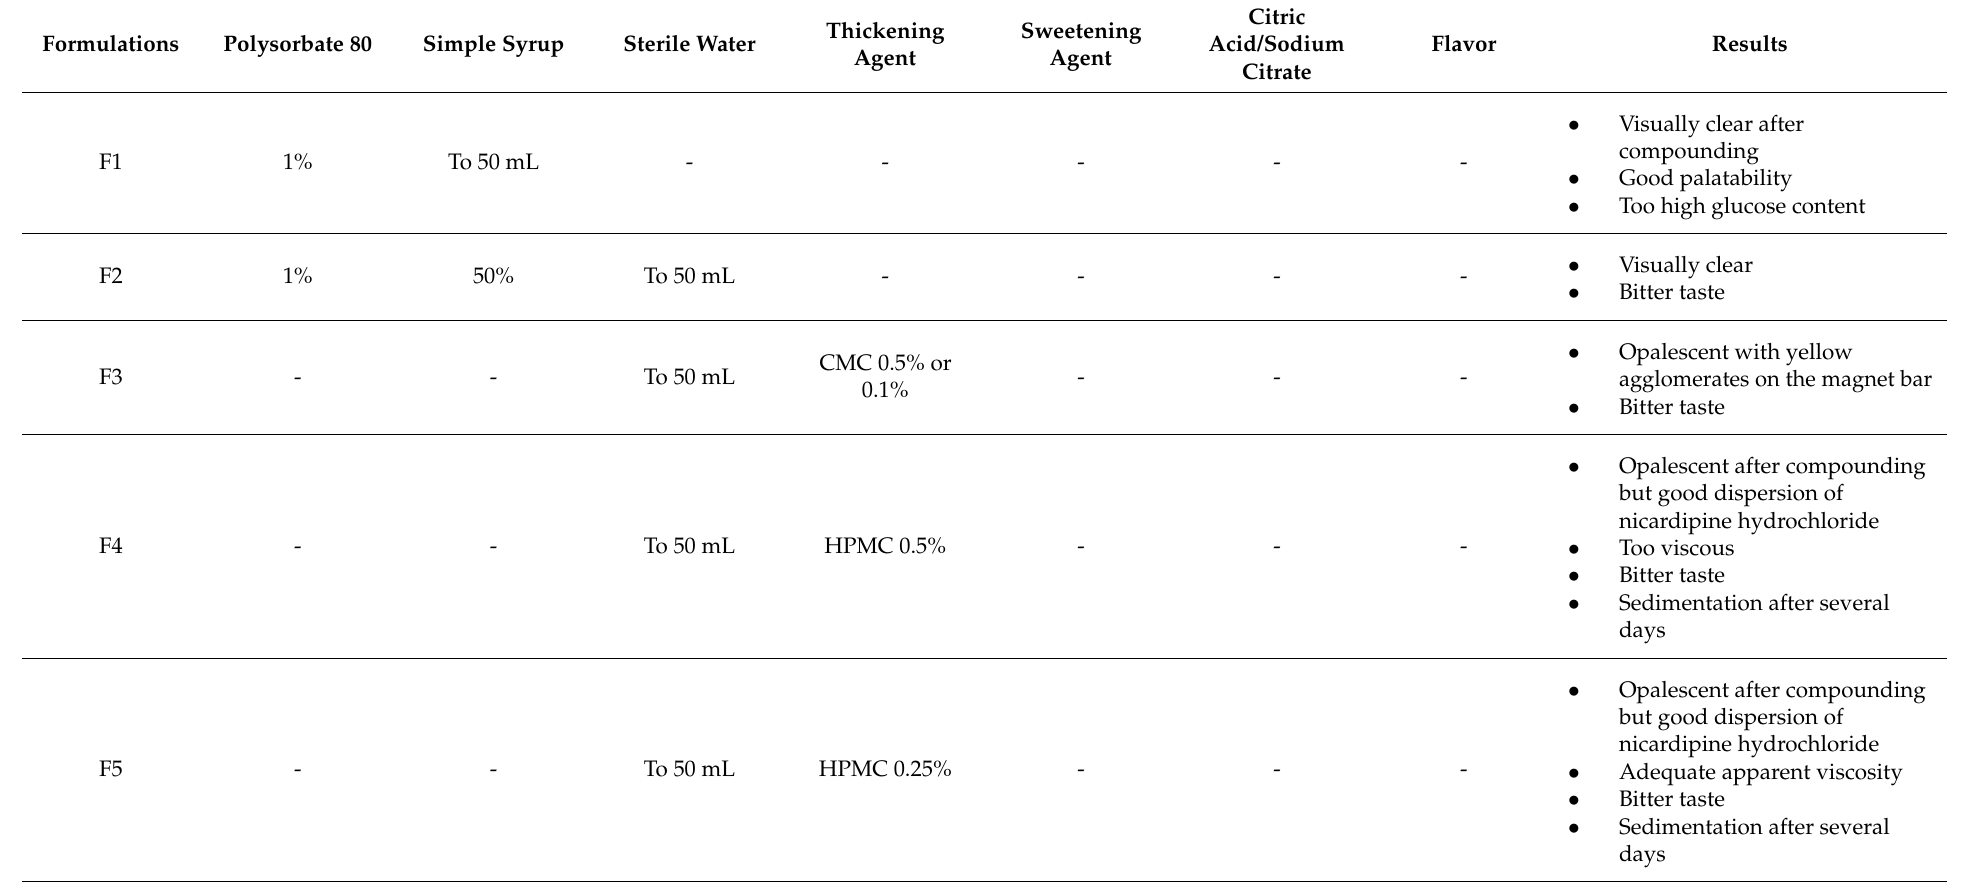
Table 2. Tested formulations of nicardipine hydrochloride 2